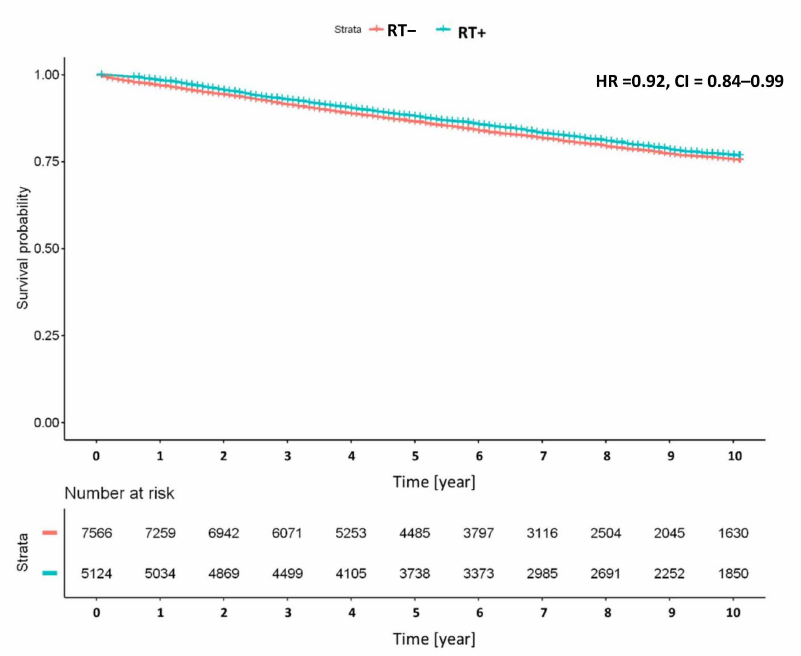
Figure 2. Kaplan-Meier survival plot of cases with and without radiotherapy, HR = hazard ratio with 95% confidence intervals.